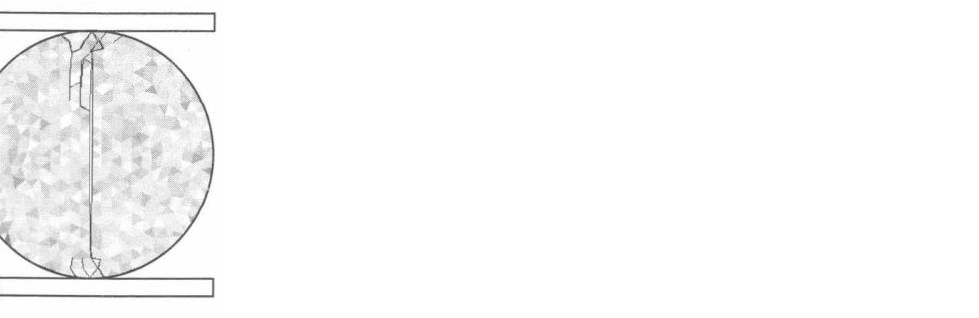
Figure 7. Results using the original DDARF to simulate the Brazilian splitting experiment (Reprinted/adapted with permission from Ref. [28]. 2007, Zhang Xiuli).